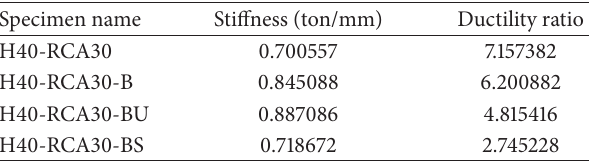
Table 9: Comparison of ductility.